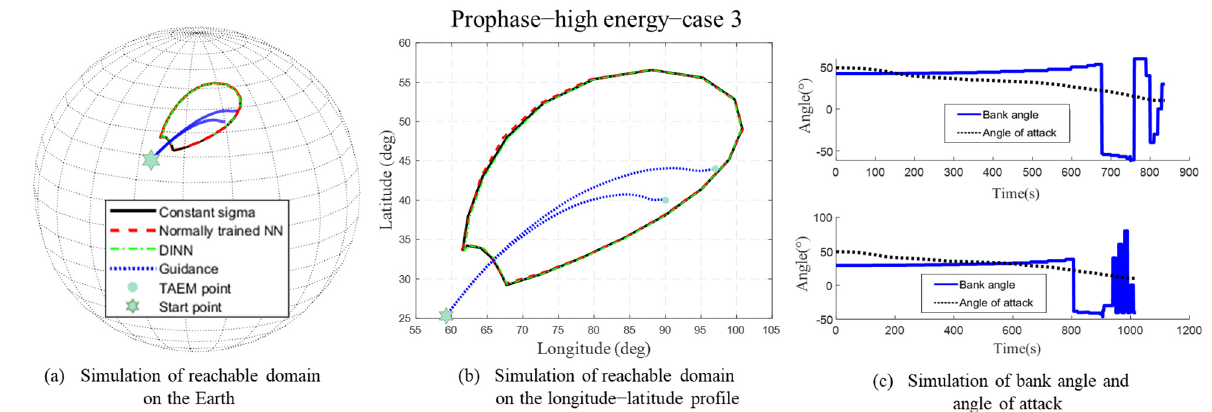
Figure 8. Simulation of high energy Case 3.